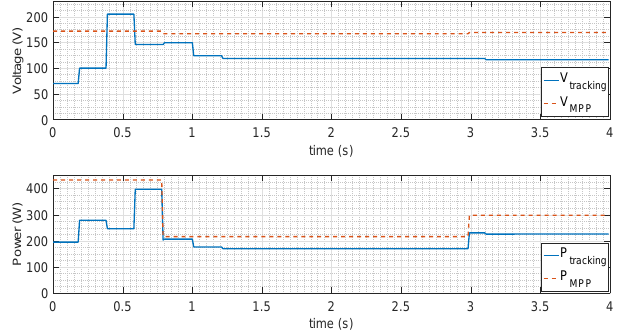
Figure 24. Tracking profile of NQI under sudden irradiance